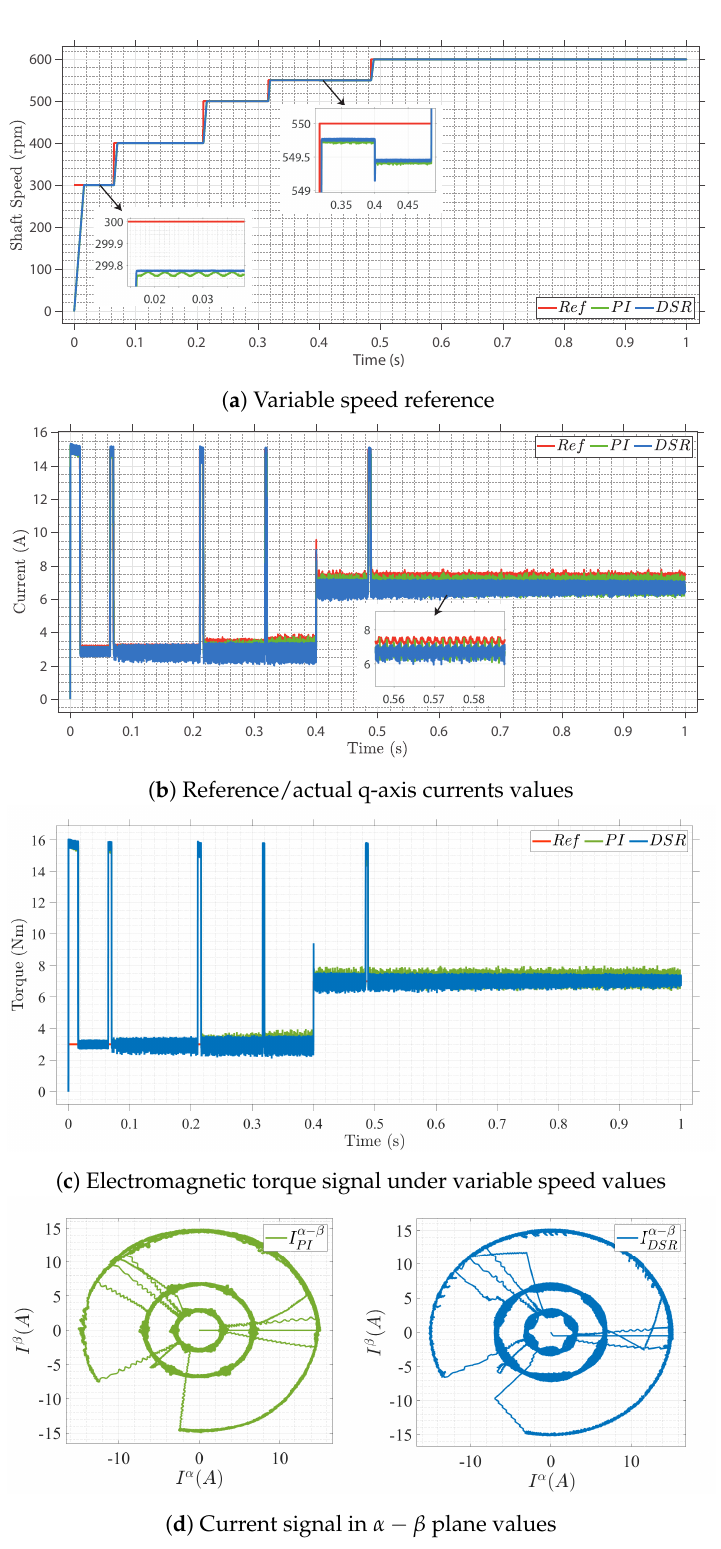
Figure 5. Closed-loop field-oriented control of SPMSM under speed